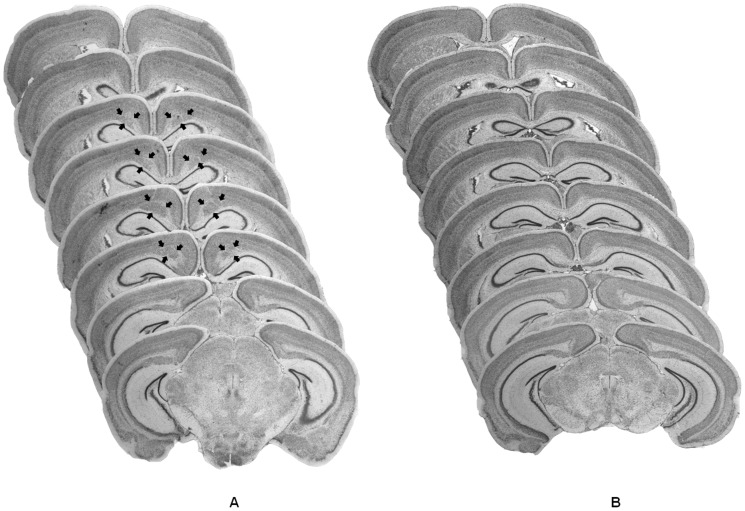
Histological examination of Nissl stained coronal sections in BXD29-Tlr4lps−2J/J mutant and BXD29/Ty wildtype mice.A) Bilateral midline subcortical nodular heterotopia are present in all BXD29-Tlr4lps−2J/J mutant mice. Black arrows indicate the boundaries of the abnormal clustering of cells within the coronal plane. B) Visualization of both male and female BXD29/Ty wildtype brains show no evidence of abnormal gross neuromorphology.